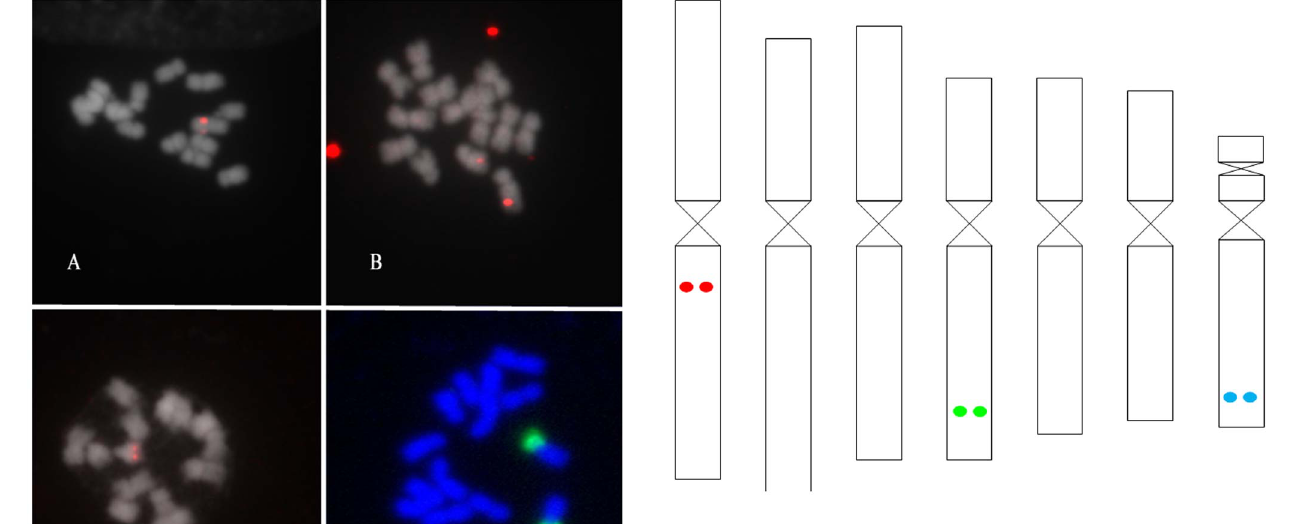
Fig. 2. Ideogram of Rosa wichurana chromosomes with an indication of the physical position of the candidate genes for OOMT (red), PAL (blue) and P5CS (green).